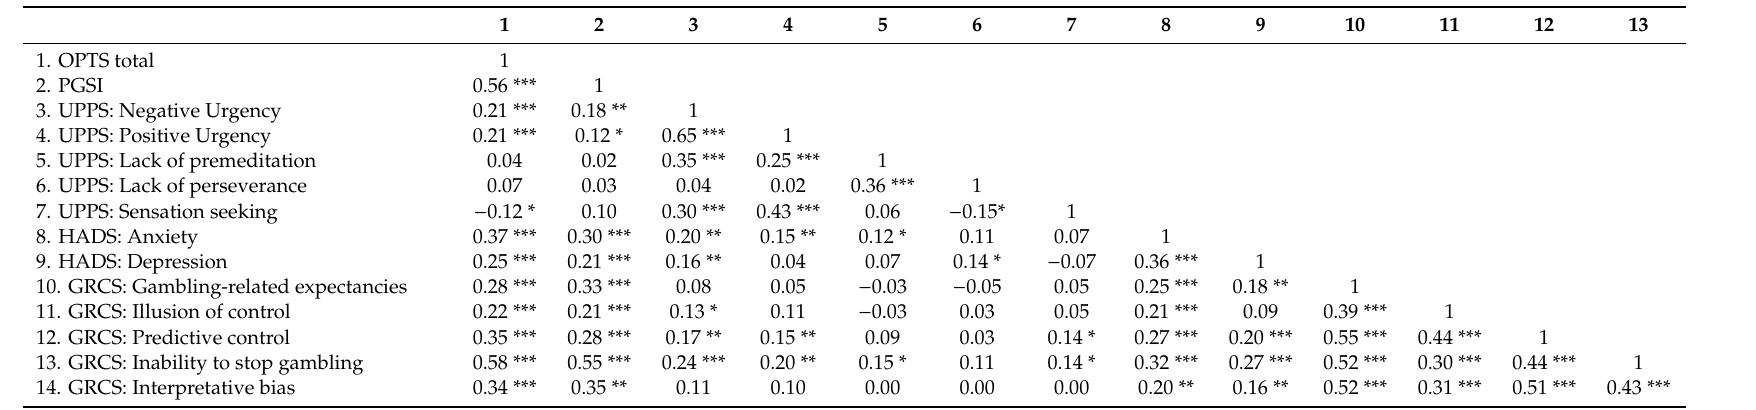
Table 3. Pearson correlations for the whole population ( n =